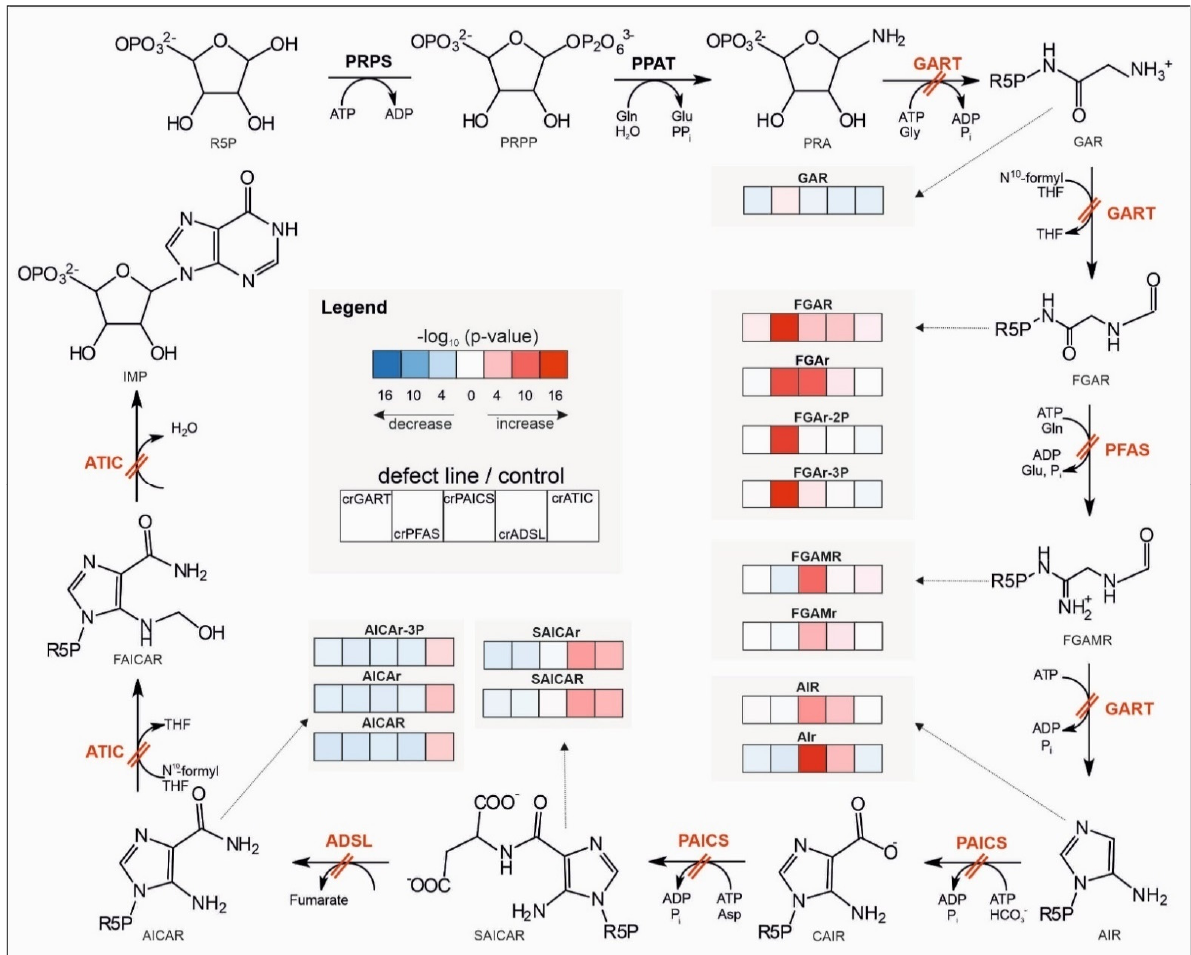
Figure 2. Accumulation of intermediates and their de-/phosphorylated forms along the PDNS pathway due to individual defects of enzymes. Enzyme defects are shown by a double red line across a particular reaction of the pathway. For a given metabolite, the blue/red color of a box represents decreased/increased level of the deficient cell line compared to controls according to ln (fold change), while the shade reflects − log10 ( p -value) with a lighter/darker color for a statistically less/more significant difference (based on a t-test). Abbreviations: phosphoribosylamine (PRA), glycinamideribonucleotide (GAR), N-formylglycinamide ribonucleotide (FGAR), diphosphate form of FGAR (FGAr-2P), triphosphate form of FGAR (FGAr-3P), N-formylglycinamidine ribonucleotide (FGAMR), aminoimidazole ribonucleotide (AIR), carboxyaminoimidazole ribonucleotide (CAIR), N-succinocarboxamide-5-aminoimidazole ribonucleotide (SAICAR), 5-aminoimidazole-4-carboxamide ribonucleotide (AICAR), triphosphate form of AICAR (AICAr-3P), 5-formamido-4-imidazolecarboxamide ribonucleotide (FAICAR), inosine-5-monophosphate (IMP), glutamine (Gln), glutamate (Glu), pyrophosphate (PPi), adenosine-5-triphosphate (ATP), adenosine-5-diphosphate (ADP), glycine (Gly), phosphate (Pi), N 10 -formyl tetrahydrofolate ( N 10 -formyl THF), tetrahydrofolate (THF), hydrogen carbonic acid (HCO 3 − ), aspartate (Asp). Riboside forms of PDNS intermediates are marked with small letter r.